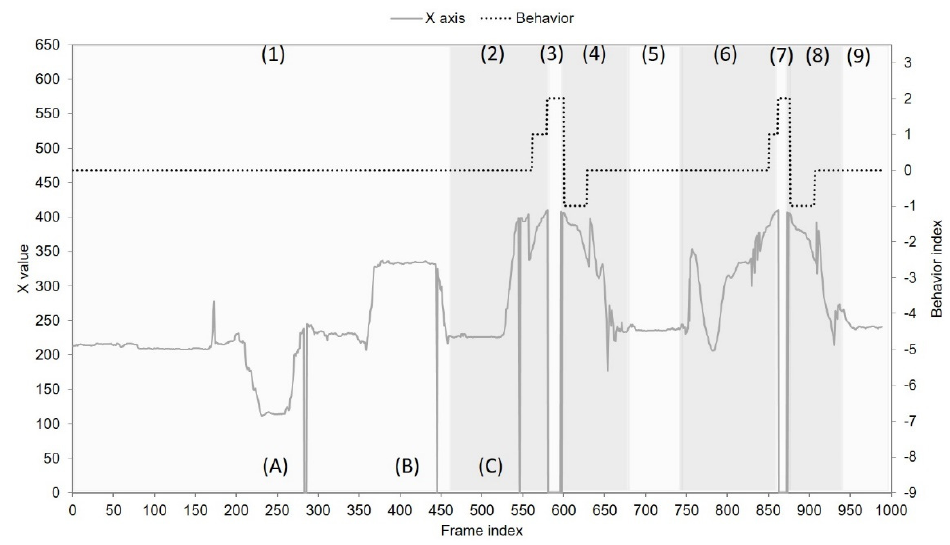
Figure 9. Behavior index trace from the horizontal low angle: numbers (1)–(9) stand for different statuses; letters (A)–(C) represent detection failure events. Table 3. Behavior recognition statistical results for different NFV camera